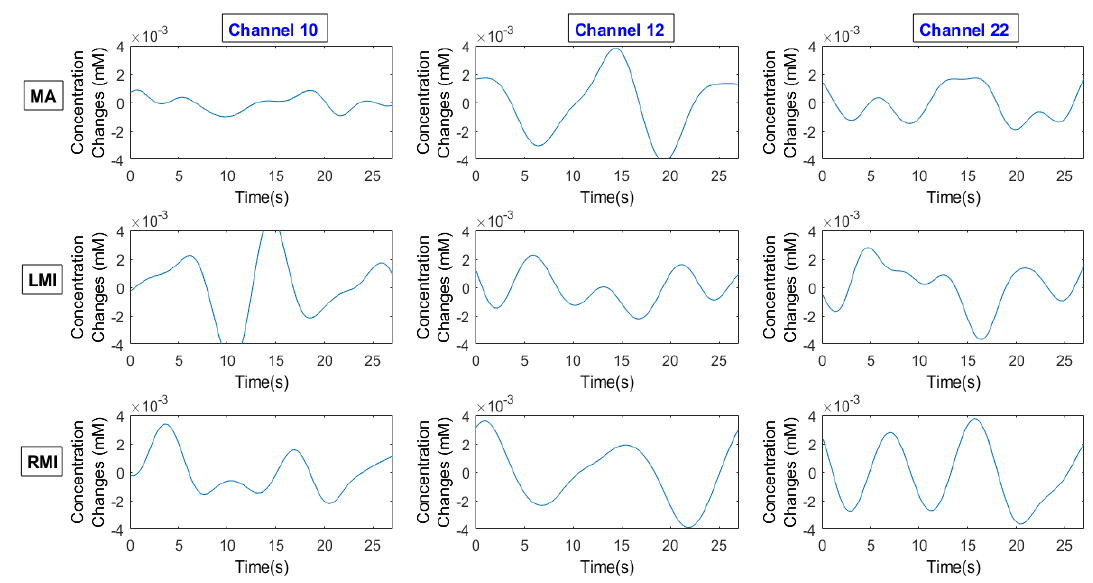
Figure 3. Averaged ∆ HbO of all trials of channels 10, 12, and 22 for tasks and rest of the MA, LMI, and RMI.